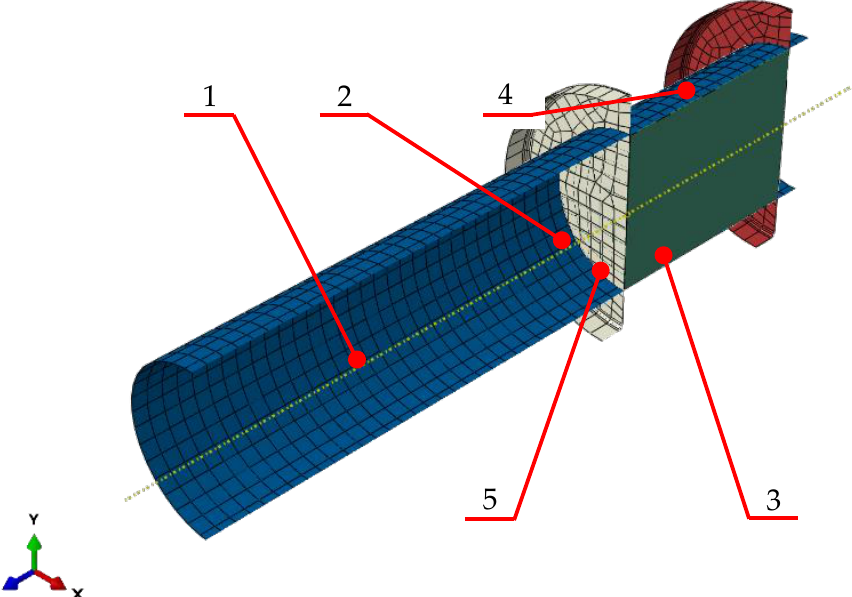
Figure 4. Numerical model: 1 barrel, 2 ram, 3 compressed dry ice, 4 dead-end disc, 5 compression force measurement point [9]. Table 1. Input data of the simulation using the MC model.